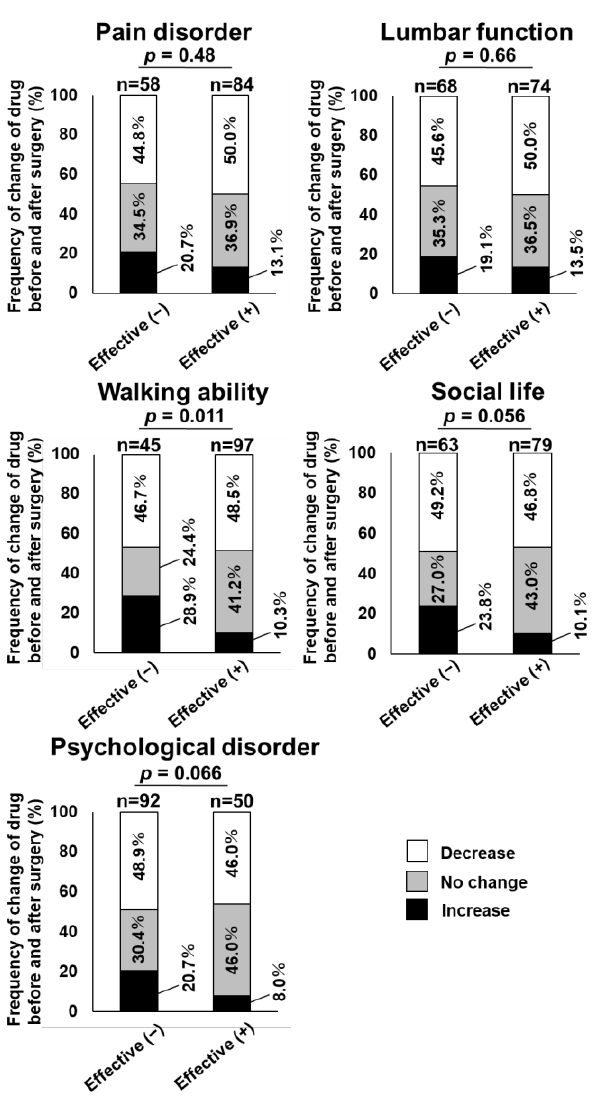
Figure 3. Comparison of the distribution of changes in the number of LSCS medications between effective and non-effective cases of surgical treatment in each domain of JOABPEQ. Walking ability showed a significant difference in the distribution of changes in the number of LSCS medications between the two groups. Social life showed a marginally significant difference, and the other three domains showed no significant difference between the two groups. Table 4. Poisson regression model for increase of LSCS medications after 1 year of surgery.